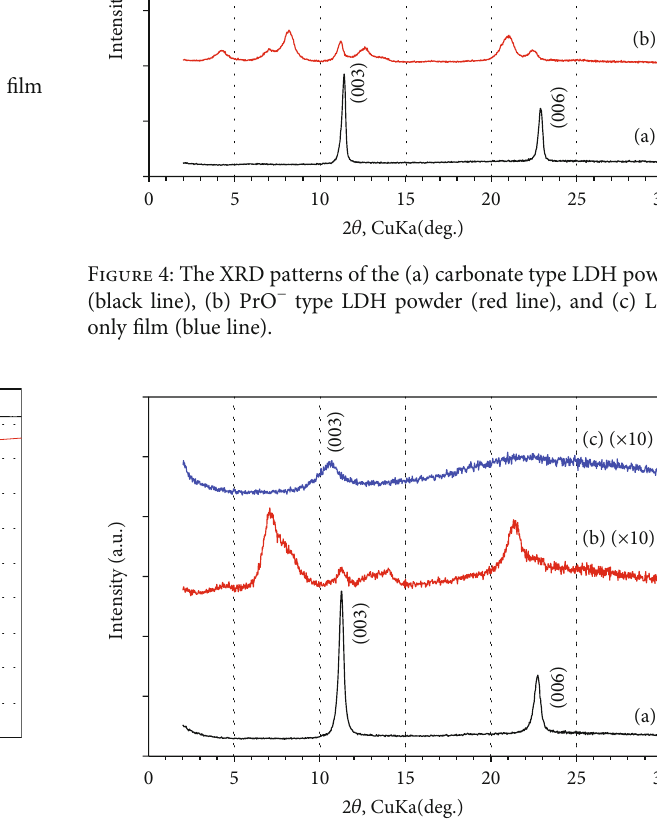
Figure 5: XRD patterns of the (a) LDH fi lm (black line), (b) AcO − type LDH fi lm (red line), and (c) Pyr − /LDH hybrid fi lm (blue